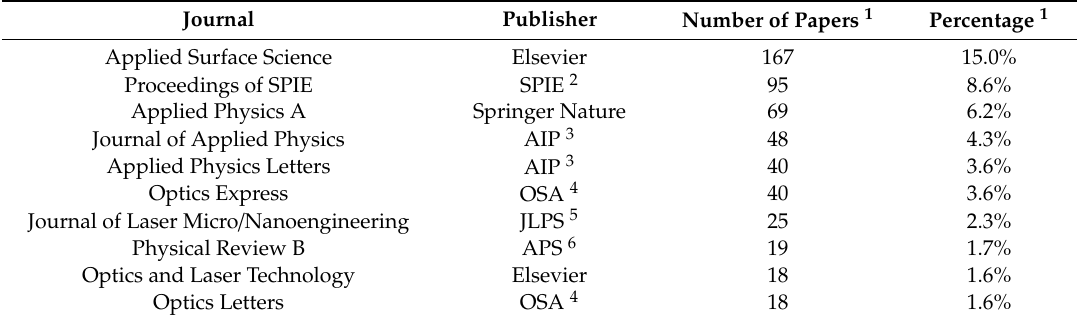
Table 2. Top 10 scientific journals and publishers with articles associated to the scientific topic LIPSS, evaluated on basis of the “ISI Web of Science” database 1